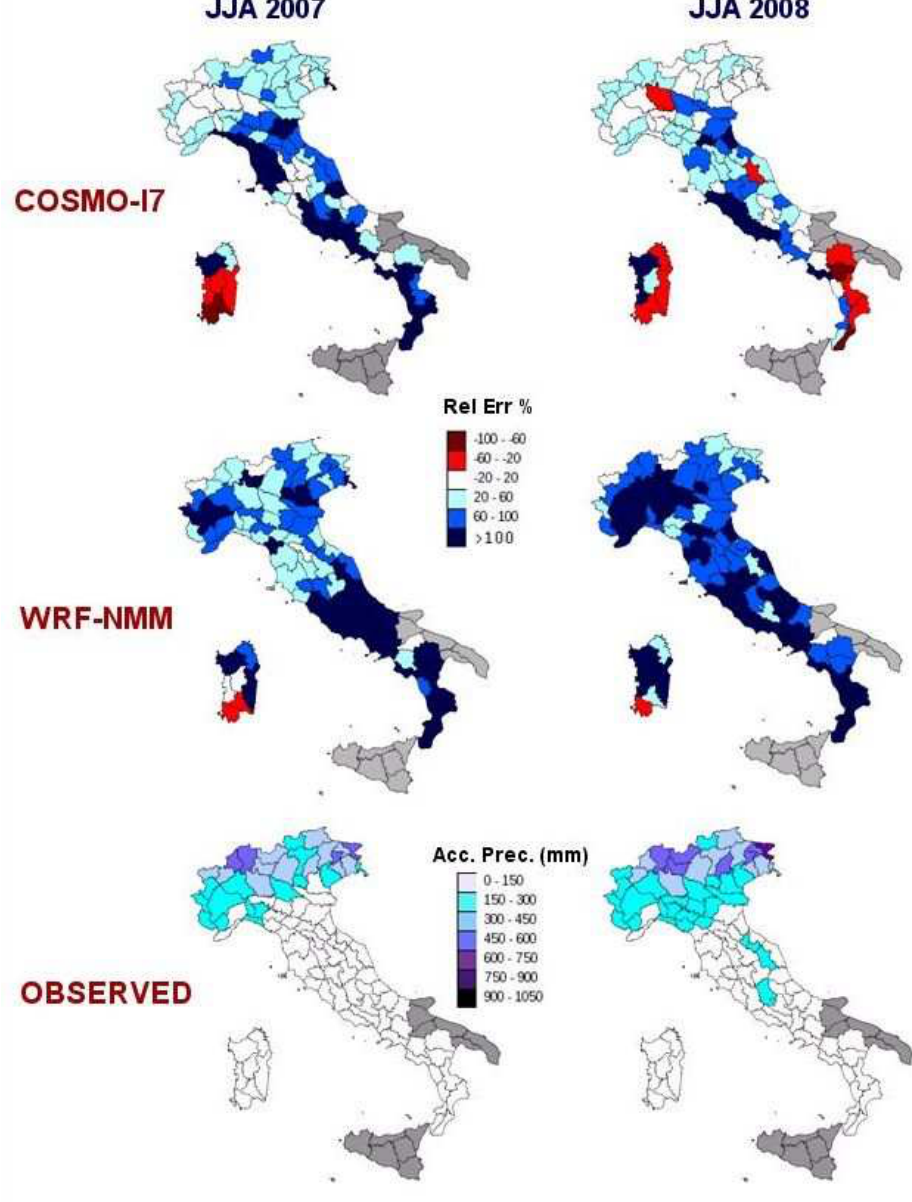
Figure 12. Model error maps (first two rows) and corresponding observed rainfall (bottom row) for summer 2007 (left column) and 2008 (right column). First row: COSMO-I7 relative errors. Second row: WRF relative errors. For relative error maps red colours means model underestimation, blue colour model overestimation.